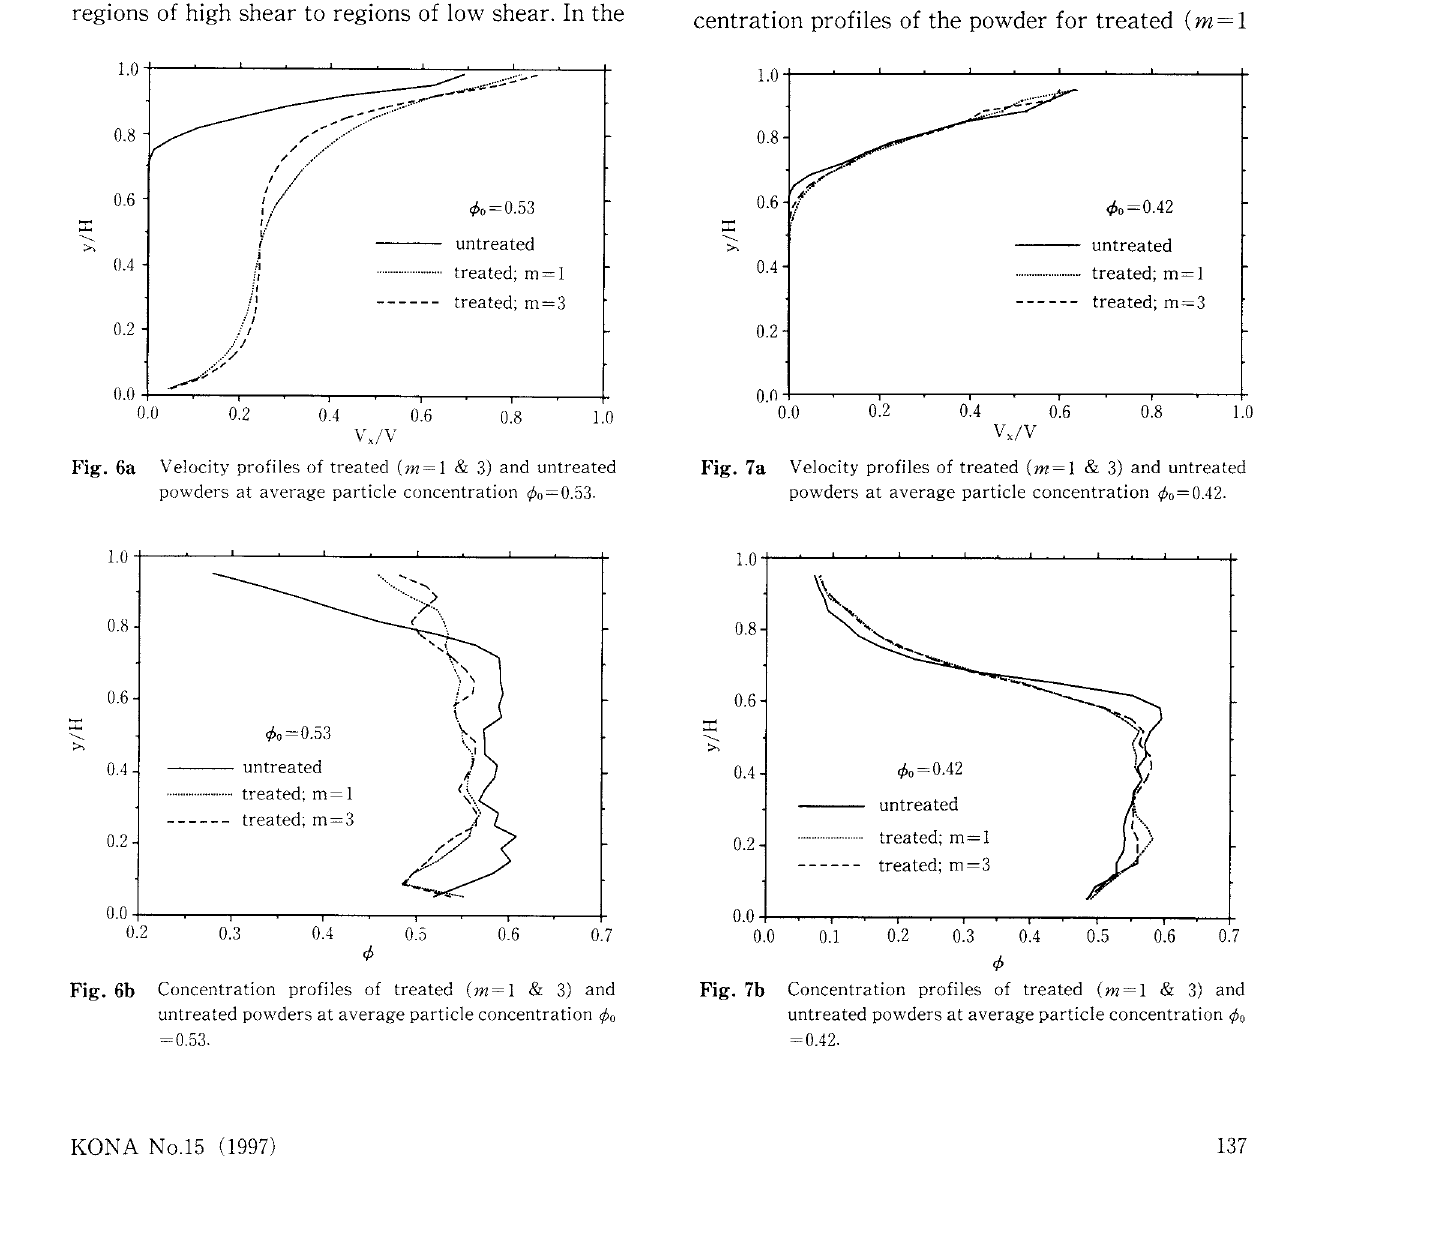
Fig. 6b Concentration profiles of treated (m=l & 3) and untreated powders at average particle concentration ¢ 0 =0.53